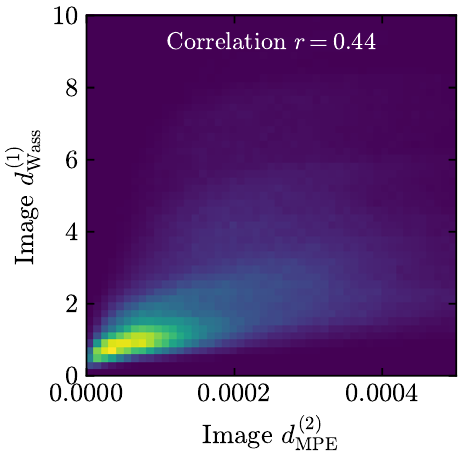
Figure 1 . The pairwise (event-to-event) distances between event images for different metrics. The mean squared error ( d (2) ) is displayed along the x -axis and the 1-Wasserstein distance ( d (1) MPE along the y